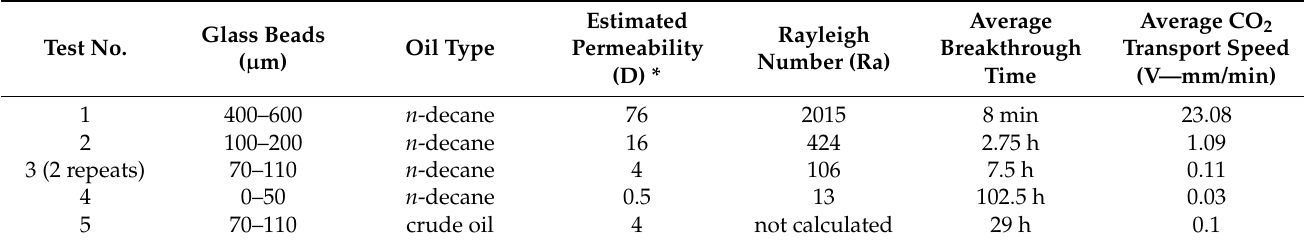
Table 2. Set of experimental cases with CO 2 /oil at 100 bar and 50 ◦ C, and average breakthrough time and average CO 2 transport speed.